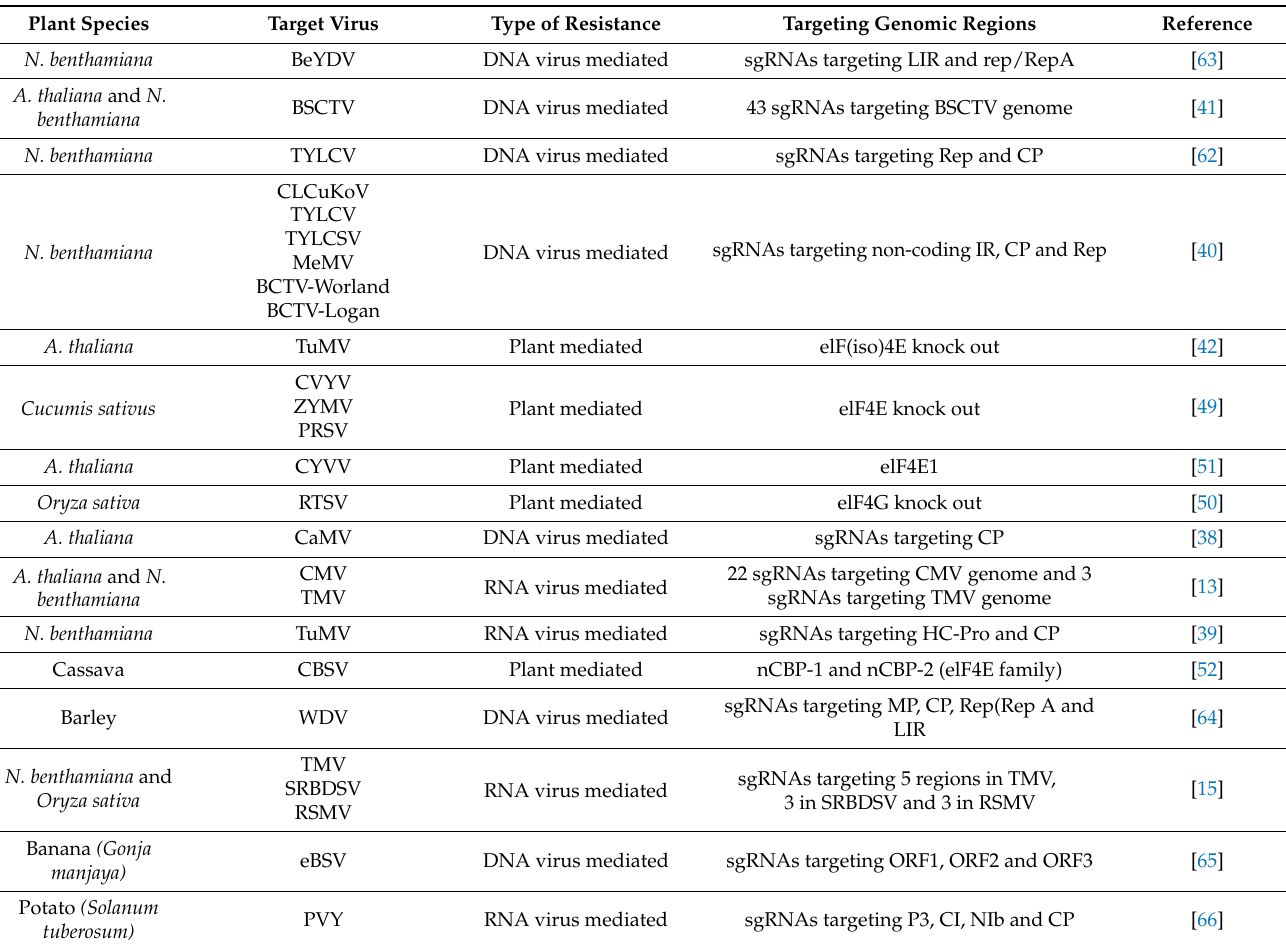
Table 1. CRISPR/Cas for viral resistance in plants by targeting viral genome (virus mediated resistance) and host factors (plant mediated